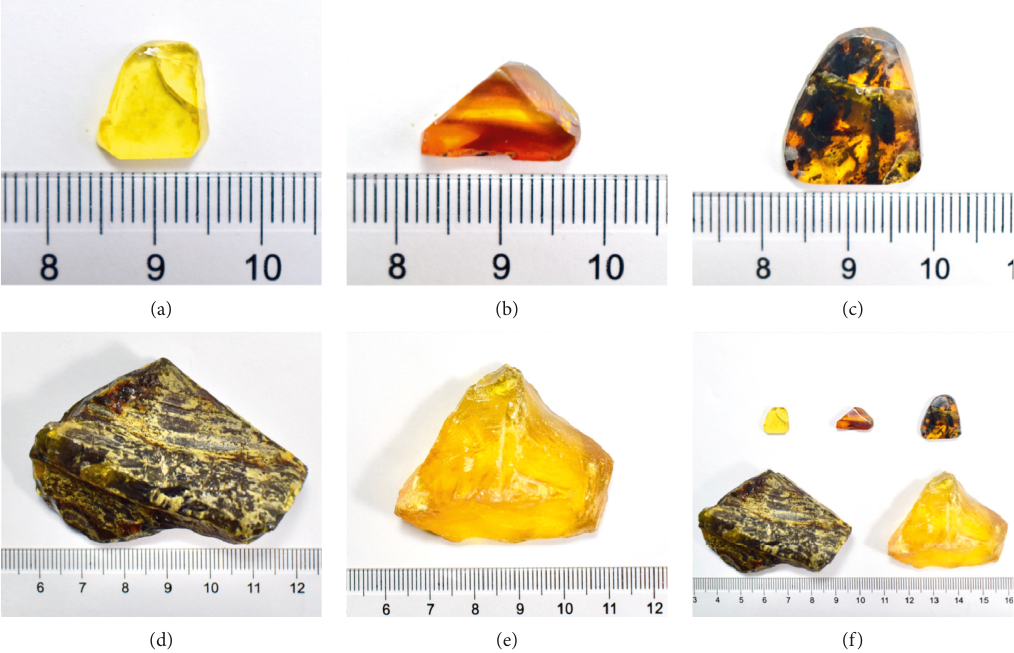
Figure 1: Photographs of experimental samples: (a) Burmese amber sample A-1; (b) Burmese amber sample A-2; (c) Burmese amber sample A-3; (d) copal sample (KB); (e) natural rosin sample (SX); (f) all specimens.